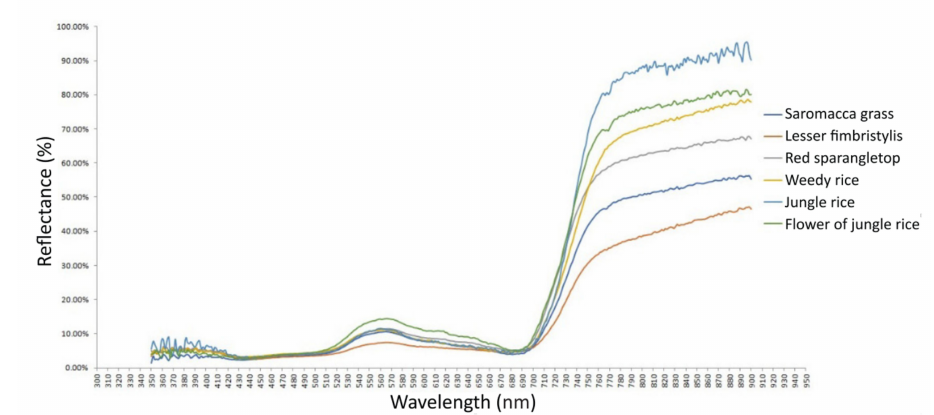
Figure 1. Spectral reflectance graph of different types of weeds in the paddy field.